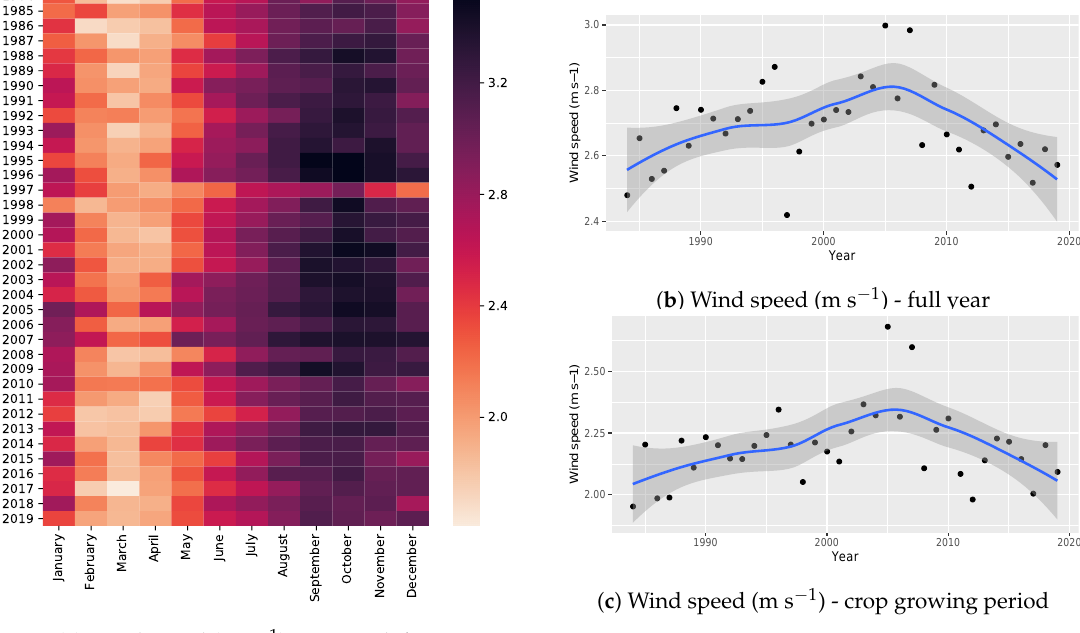
( a ) Wind speed (m s − 1 ) per month/year Figure A15. Time series of average wind speed (m s − 1 ) in Manabi from 1984 to 2019. ( a ) Heat-map of wind speed (m s − 1 ) per each month and year. The color scale represents the wind speed in m s − 1 . ( b ) Wind speed averaged during the full year. ( c ) Wind speed averaged during the maize crop growing period in Ecuador (January–May). Each dot represents one record, the blue line shows the smoothed time series and the shaded area represents the 95% confidence